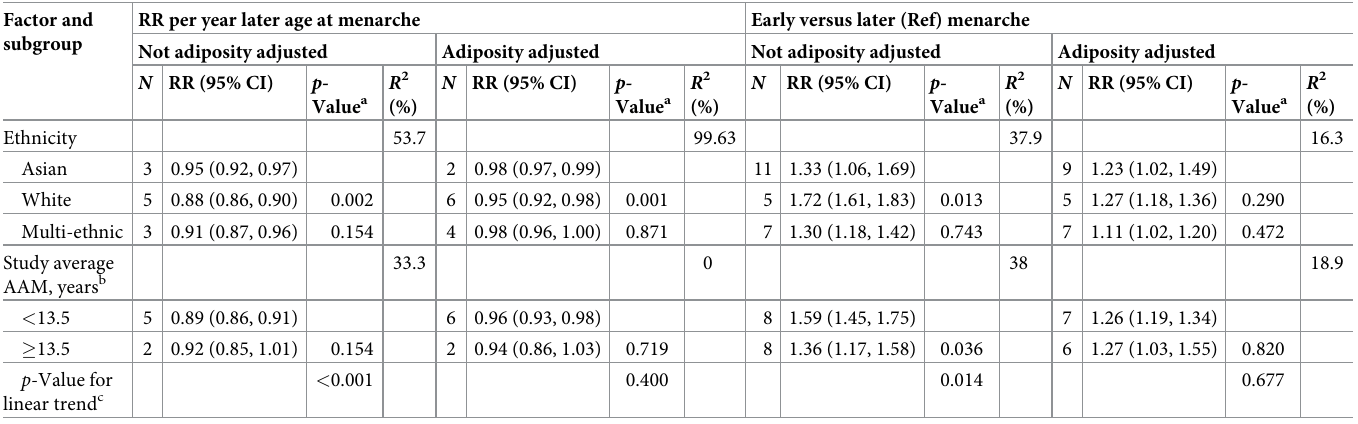
Fig 3. Forest plots of the association between early versus later menarche and T2D/IGT, without and with adjustment for adiposity. (A) Without and (B) with adjustment for adiposity. Two cohort studies in He, 2010 [41]. AAM, age at menarche; IGT, impaired glucose tolerance; RR, relative risk; T2D, type 2 diabetes.